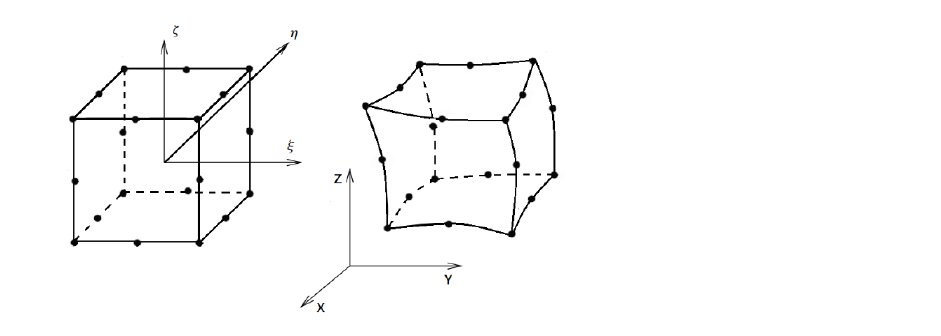
Figure A4. Cartesian global and local curvilinear coordinates of the second-order 20-node serendipity brick FE. Table A4. The shape functions of the second-order 20-node serendipity brick FE.